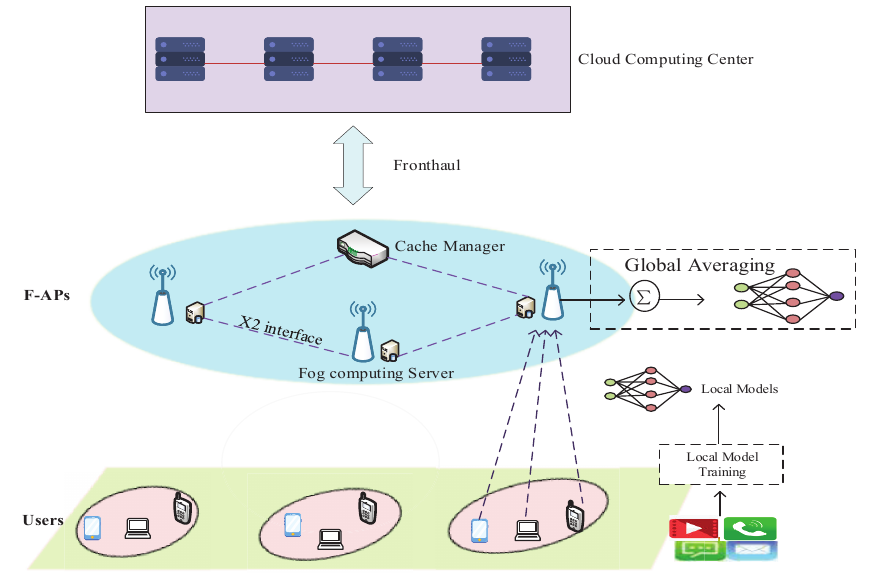
Figure 1. Federated learning paradigms in